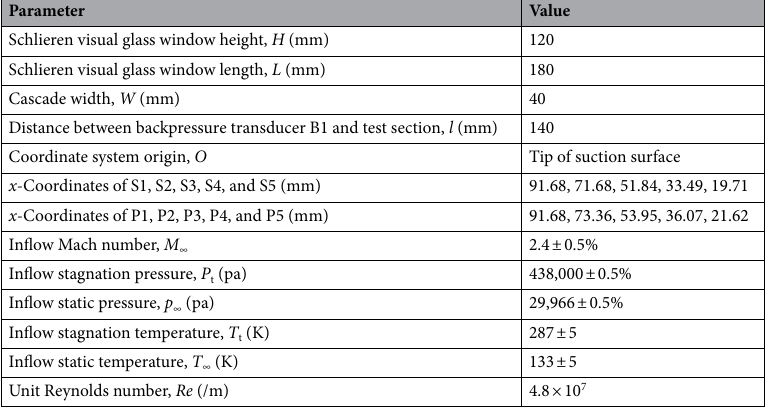
Table 1. Main geometrical parameters and freestream conditions 38 .